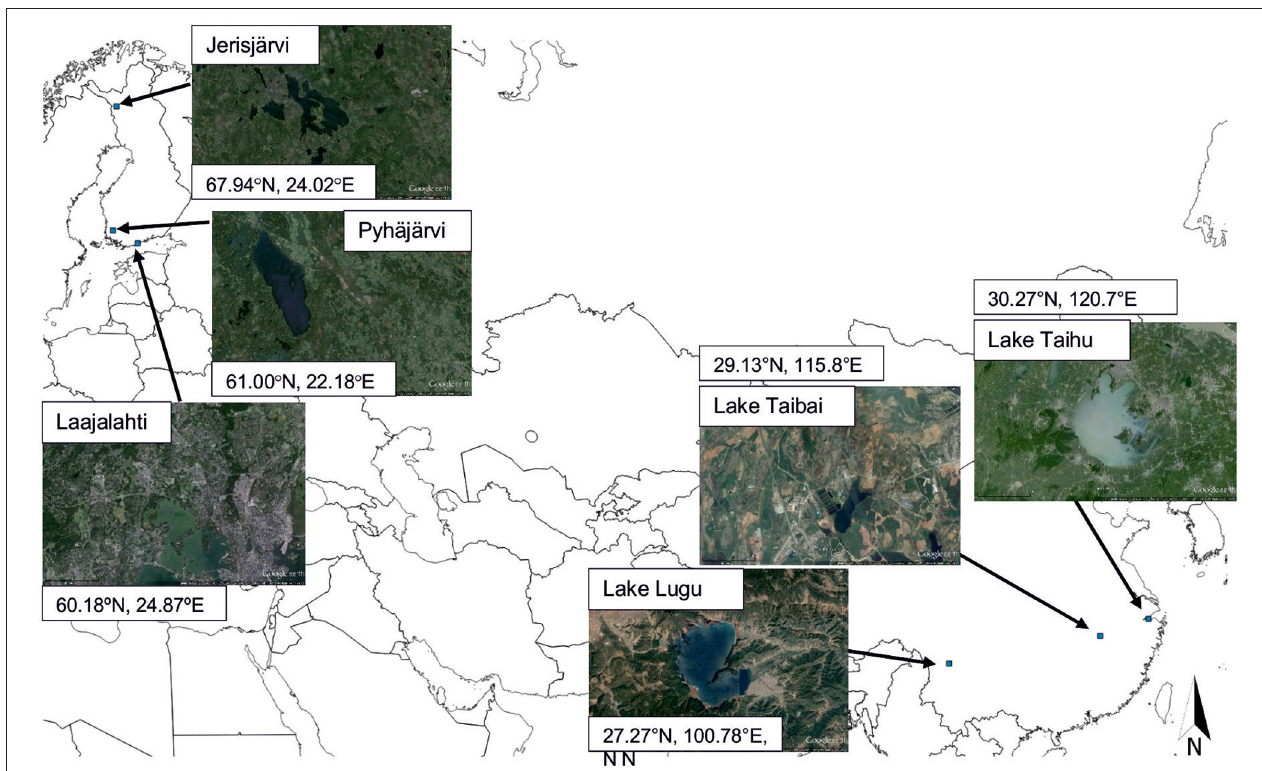
FIGURE 1 | Location of the study